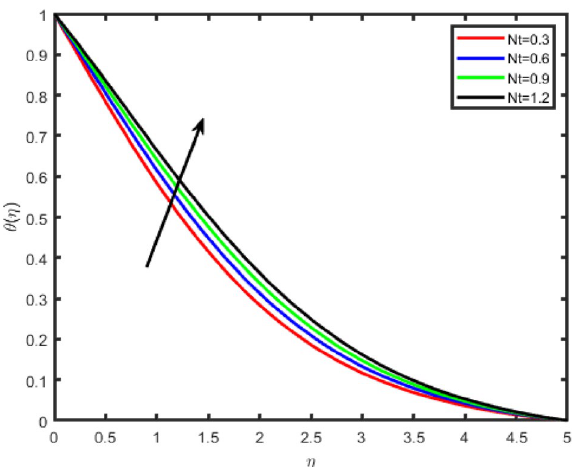
Figure 22. Effect of thermophoresis parameter (Nt) on temperature